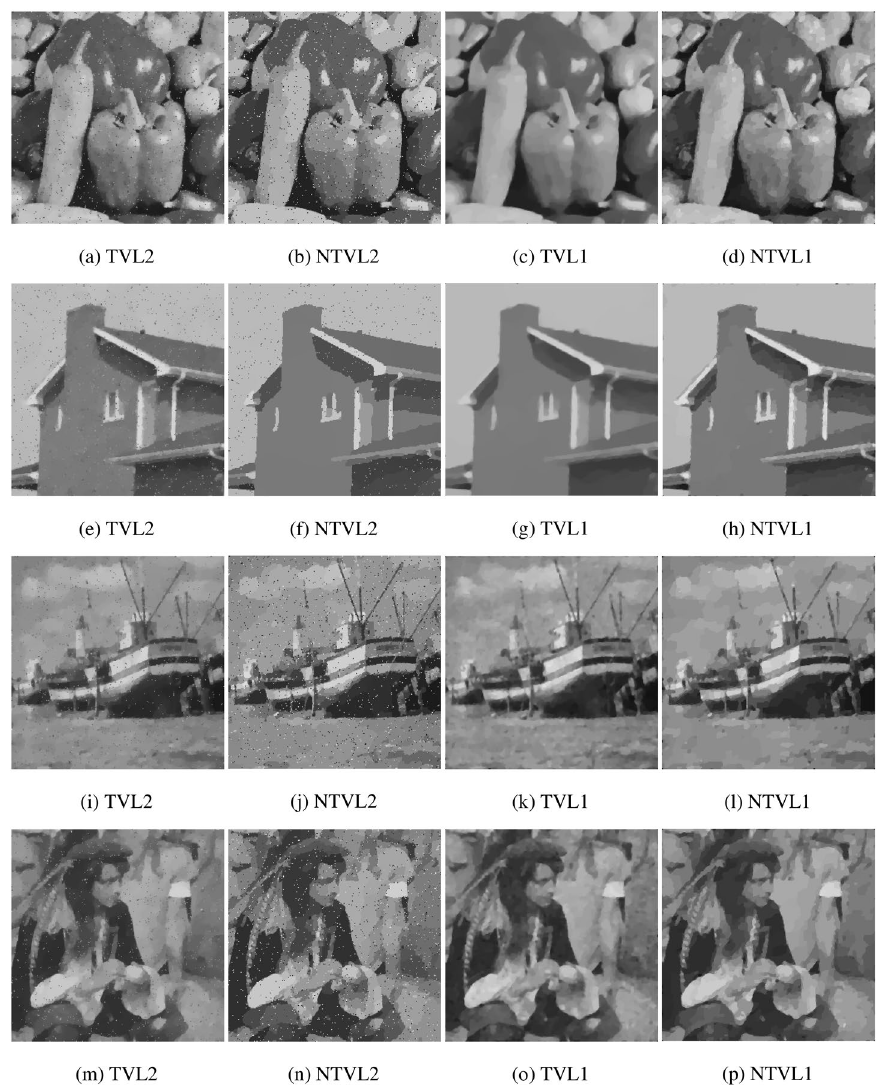
Figure 10. The denoising results of noisy Pepper, House, Boats and